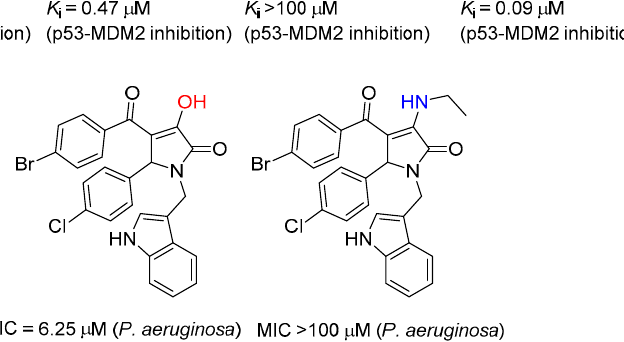
Figure 1. Biologically active compounds containing 3-hydroxy-1,5-dihydro-2 H -pyrrol-2-one (HDP) and 3-amino-1,5-dihydro-2 H -pyrrol-2-one (ADP) scaffolds. MDM2 – mouse double minute 2 homolog [1,2]; p53 – cellular tumor antigen p53 [1,2]; K i – inhibition constant [1,2]; MIC – mini- mum inhibitory concentration [9]; CC 50 – cytotoxic concentration 50% [9]; P. aeruginosa – Pseudomo- nas aeruginosa [9]; CCRF-CEM – human leukemic lymphoblasts cell line [9]. There are three universal strategies towards ADPs enabling their synthesis with a wide range of substituents (Scheme 1). These strategies are the substitution of hydroxyl groups in the corresponding HDPs via their reactions with amines (pathway a ) [1,2,7,9– 12], the multicomponent reactions of amines and aldehydes with pyruvic acid derivatives (pathway b ) [13,14] or acetylenedicarboxylates (pathway c ) [15,16] (Scheme 1).